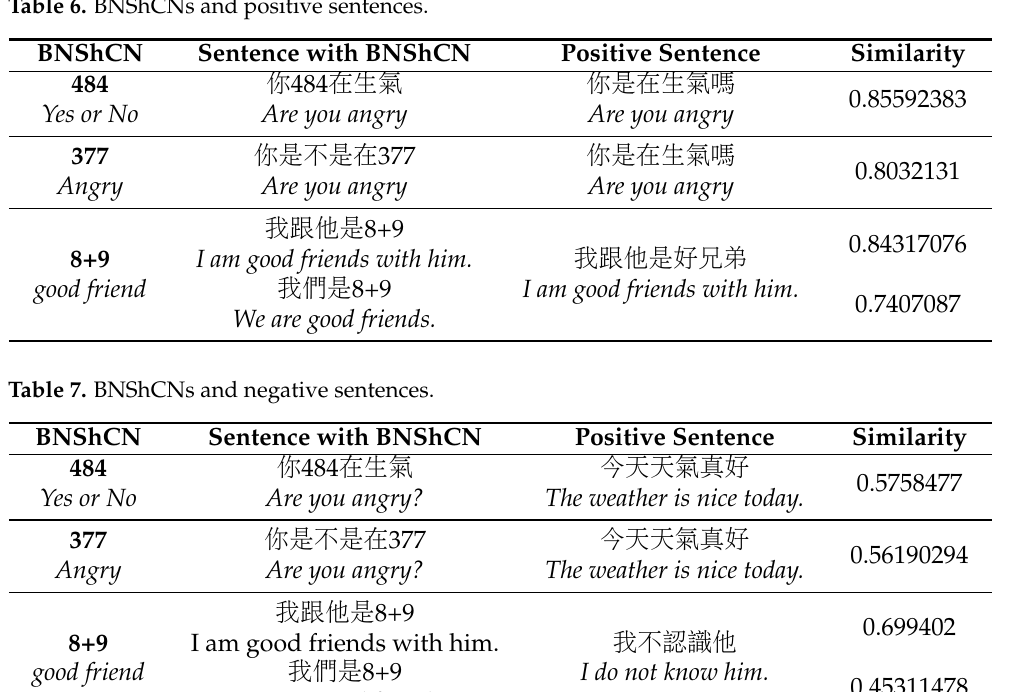
Table 6. BNShCNs and positive sentences.